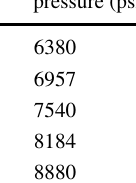
Table 11 Effect of different production rates on bottom hole pressure